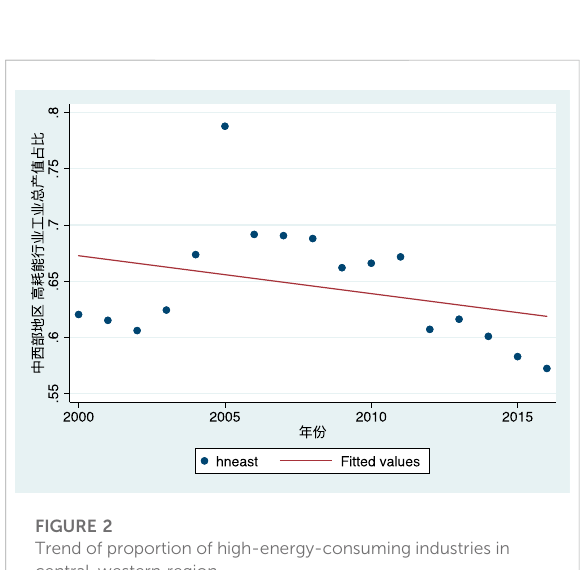
FIGURE 2 Trend of proportion of high-energy-consuming industries in central-western